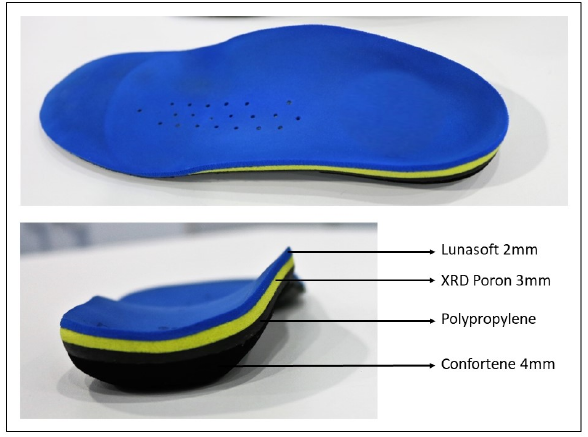
Figure 1. Custom-made polypropylene foot orthosis components.